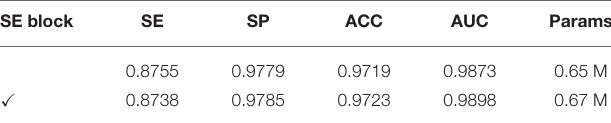
TABLE 6 | Ablation study for squeeze and excitation (SE) block.